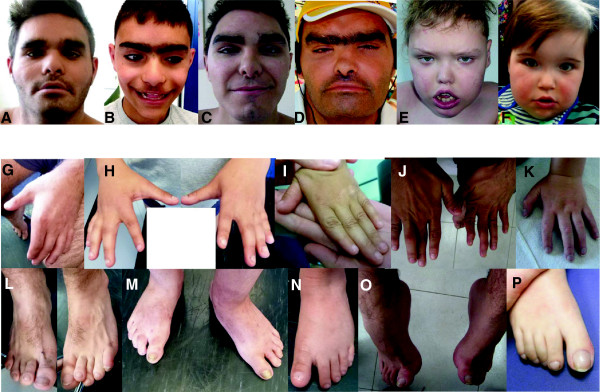
Clinical photographs of our cohort. Upper row (A-F): Facial phenotypes. Facial phenotype is characterized by a broad face, flat midface, synophrys and/or prominent eyebrows, almond shaped eyes, low nasal bridge, prominent columella of the nose, hypoplastic alae nasi, and macrostomia. A: Patient 1 (family A) at age 19 years, B: Patient 2 (brother of Patient 1, family A) at age 11 years, C: Patient 4 (family B) at age 15 years, D: Patient 5 (family B) at age 38 years, E: Patient 6 at age 7 years, F: Patient 7 at age 5 years. Depending on the ethnic background, synophrys can be only very mild or even absent in individuals with light skin and hair pigmentation (e.g. Patients 6 and 8). Middle row (G-K) Hands of patients in our cohort with proximally inserted thumbs and short distal phalanges. G: Patient 1. H: Patient 2. I: Patient 3. J: Patient 4. K: Patient 6. Lower row (A-F) Feet. L: Patient 1 with onychodystrophy especially of the first and fifth toe nail (on the right respectively left hand side). M: Patient 2 with onychodystrophy and sandal gap. N: Patient 3 with sandal gap (status after trauma of the first toe nail). O: Patient 4 with pes cavus. P: Patient 6 with clubbed toe nail.